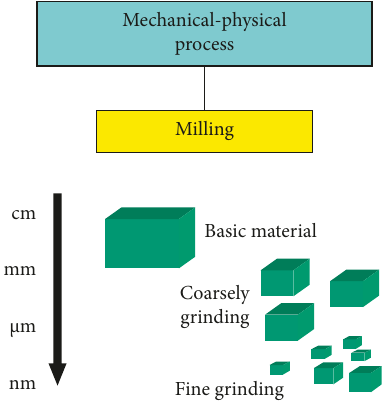
Figure 1: The schematic diagram for preparing nanoparticles by mechanical method [4].